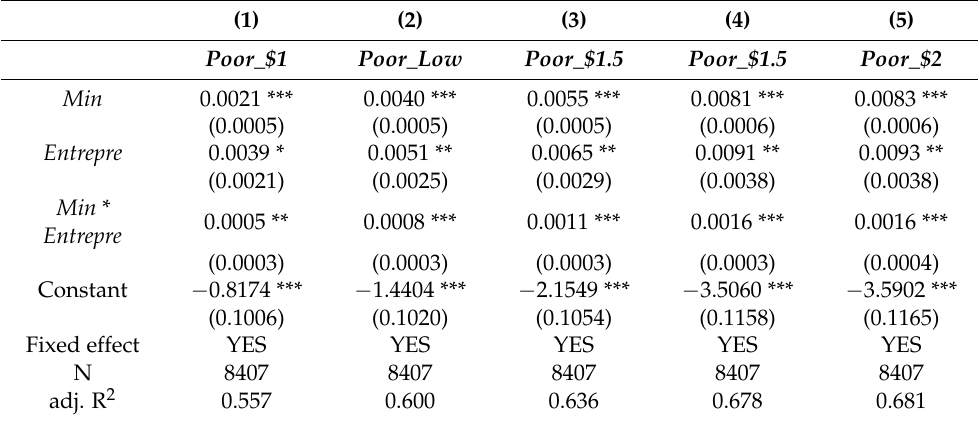
Table 15. Impact of extreme low temperature on poverty vulnerability—entrepreneurship.